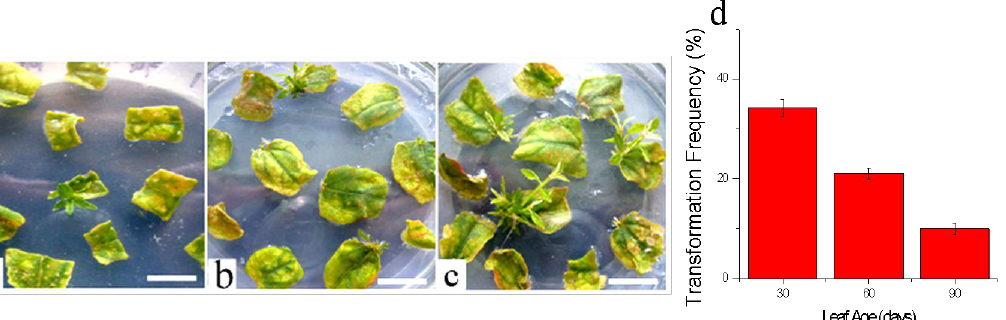
Figure 4. Transgenic shoot on regeneration-selection medium containing 50 mg/L Kan and 200 mg/L Cef. ( a ) 90-day-old leaf; ( b ) 60-day-old leaf; ( c ) 30-day-old leaf. Scale bar 1 cm. ( d ) Transformation percentage per leaf age from more than 100